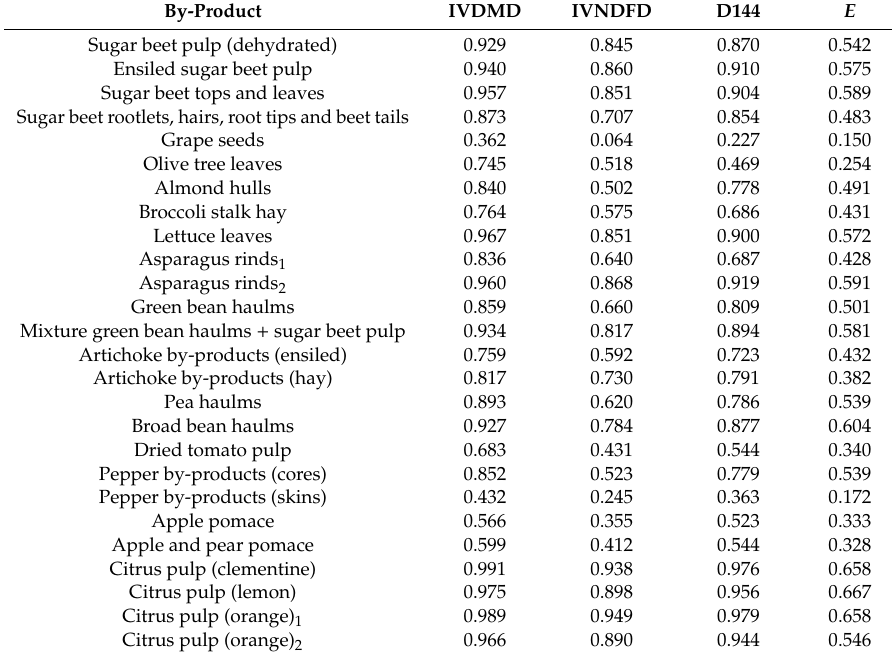
Table 4. In vitro digestibility and extent of ruminal degradation of the